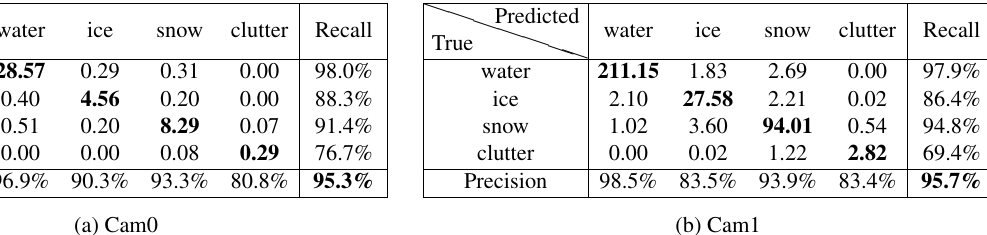
Figure 3. (a): Schematic illustration of the segmentation framework. The encoder down-samples the image, and thereby increases the field of view. It consists of a sequence of dense blocks (DB) and transition down (TD) blocks. The decoder performs up-sampling of feature maps with a sequence of dense blocks (DB) and transition-up (TU) blocks. To recover high-resolution detail, skip connections pass information from intermediate encoder stages to the corresponding decoder stages. (b): Internal structure of a dense block with two layers and growth rate 3. For more details, see Section 3.2.